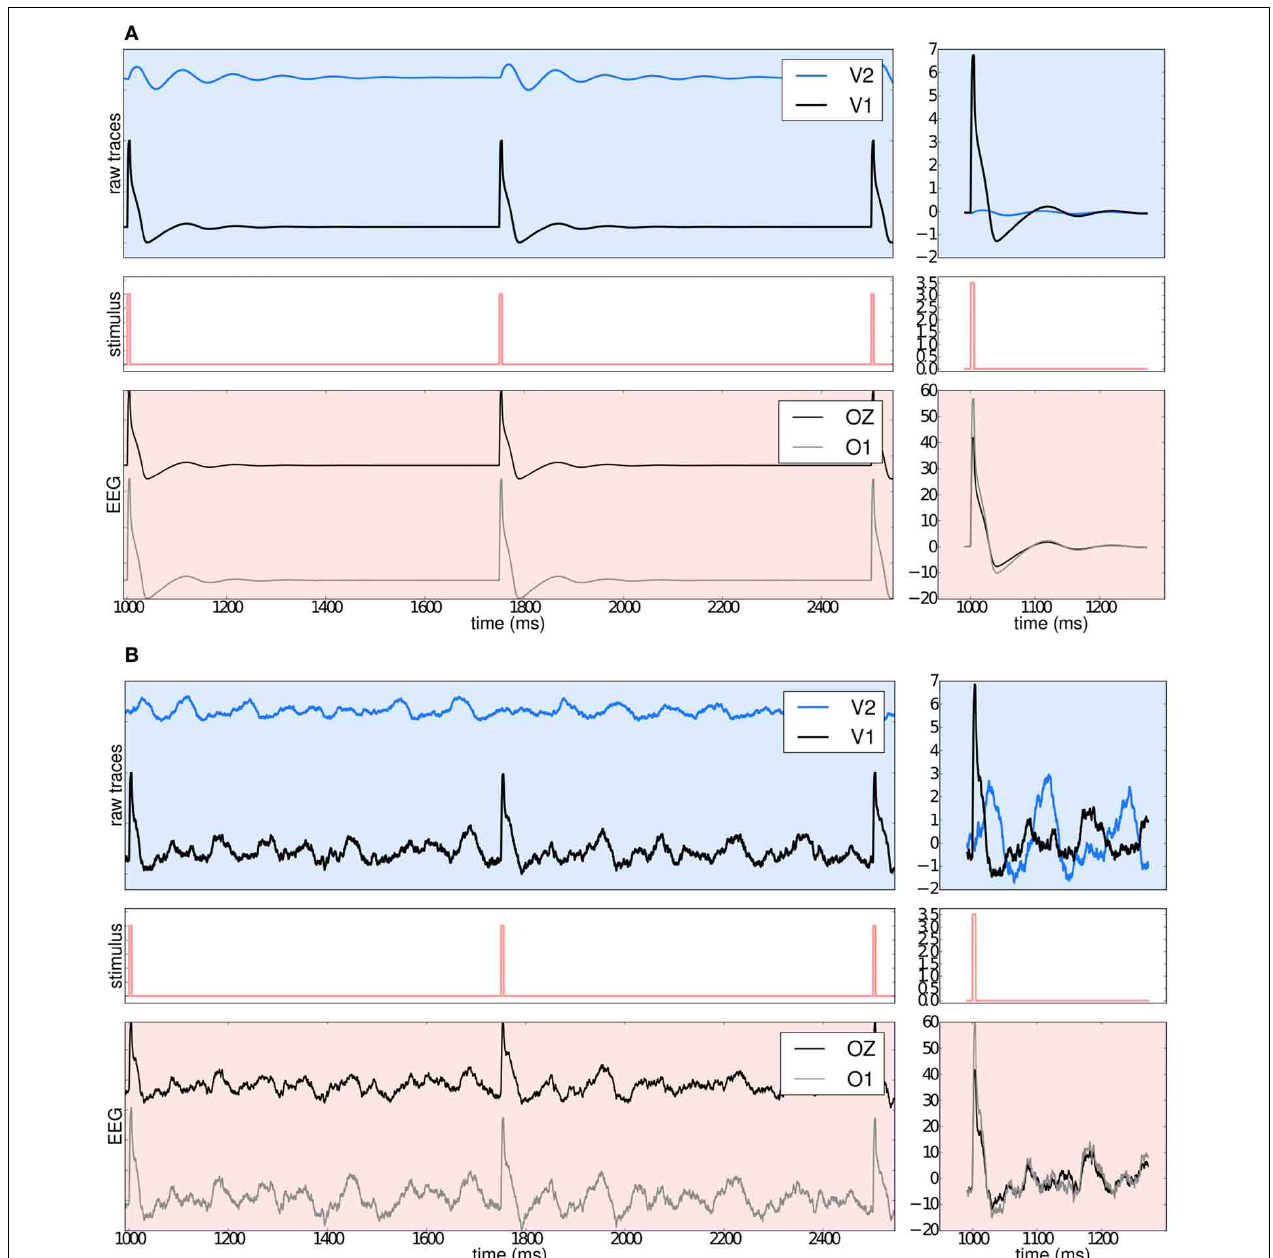
FIGURE 11 | (A) The upper left blue panel shows the raw traces of nodes V2 and V1; the latter stimulated with a rectangular pulse of width equal to 5ms and repetition frequency of 1Hz. Signals are normalized by their corresponding maximum value. The right blue panel show the signals for a shorter period of time. Amplitudes are not normalized to emphasize the relative difference between the two regions. Middle panels illustrate the stimulus pattern. Lower red panels display the activity as projected onto EEG